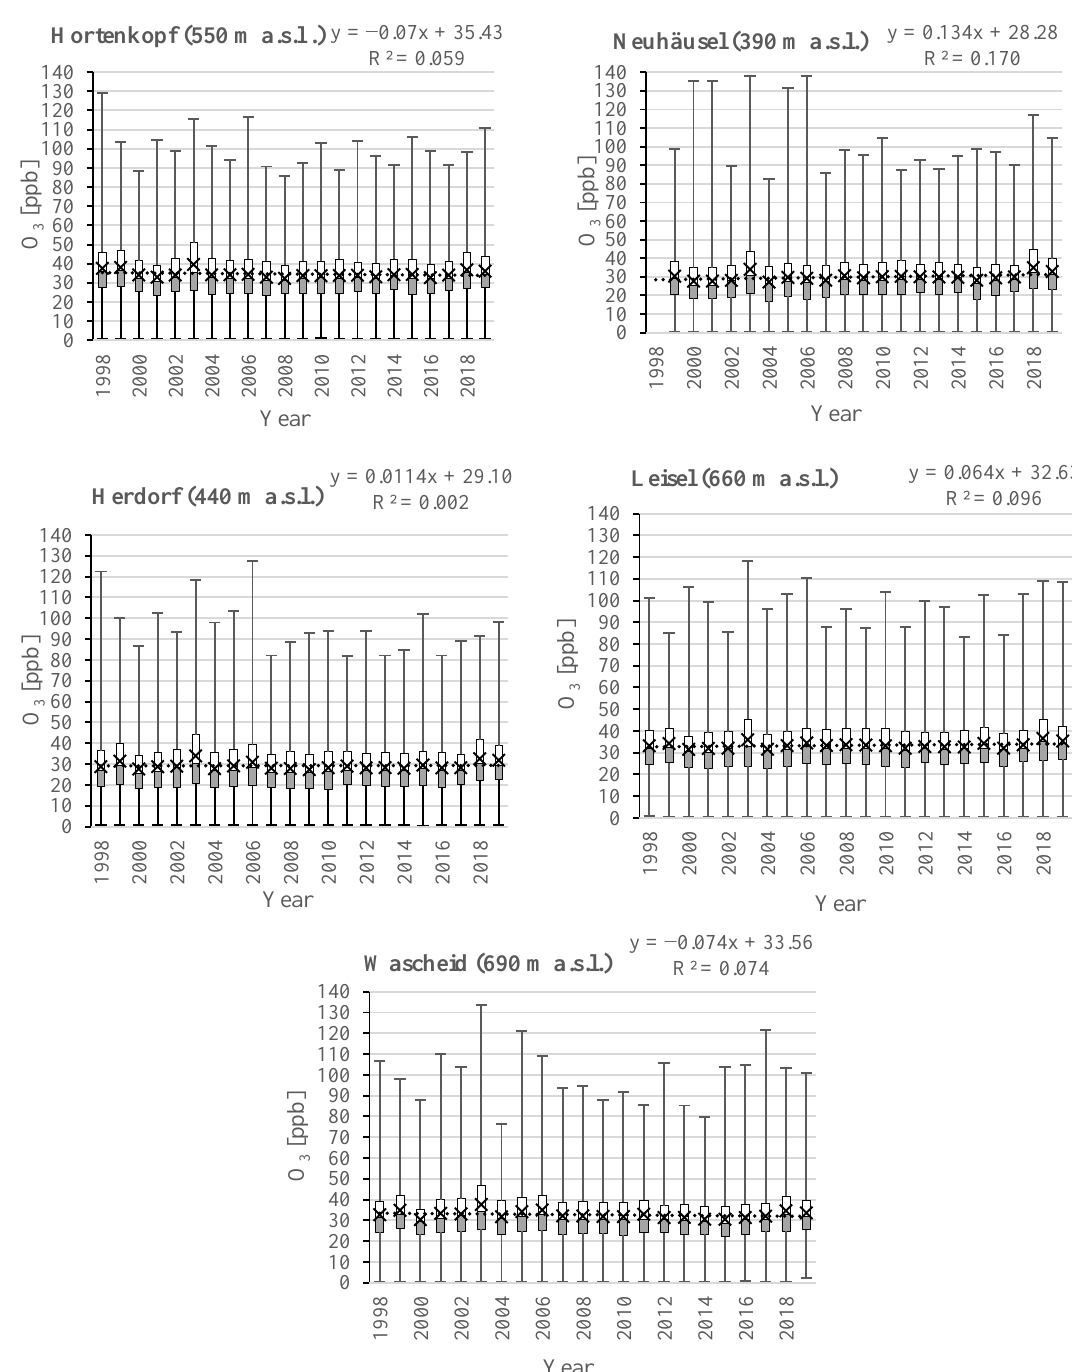
Figure 2. Boxplots of hourly O 3 concentrations (ppb) showing annual variance and temporal trends of the sites. The temporal trend is shown as the regression line (pointed line) of annual means (crosses) for n = 22 years (except for Neuhäusel with n = 21) with the regression equation and coefficient of determination. The significances of the temporal trends are documented in Table 3. The end of the upper and lower whiskers represent the hourly maximum or minimum values of the year, respectively. The line between the first and third quartile characterizes the annual median.